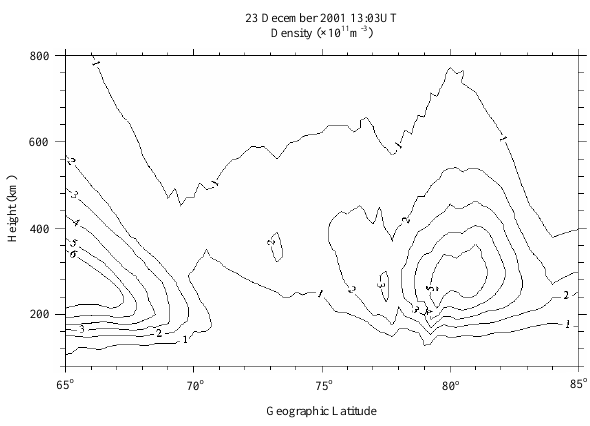
Fig. 1. Tomography image from a satellite pass crossing a latitude of 75 ◦ N at 13:03 UT on 23 December